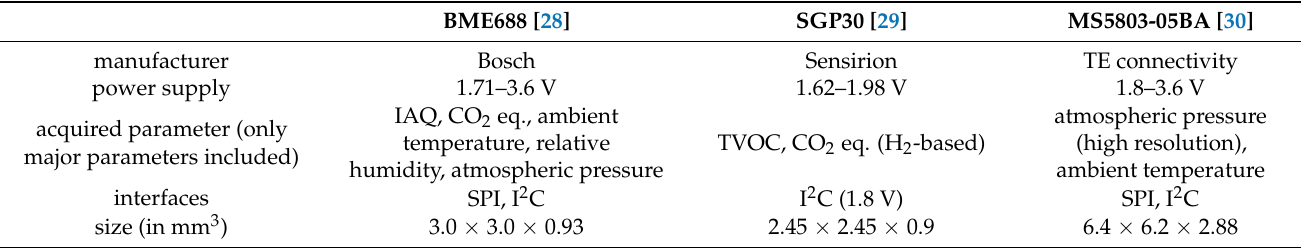
Table 1. Integrated sensor solutions and their basic